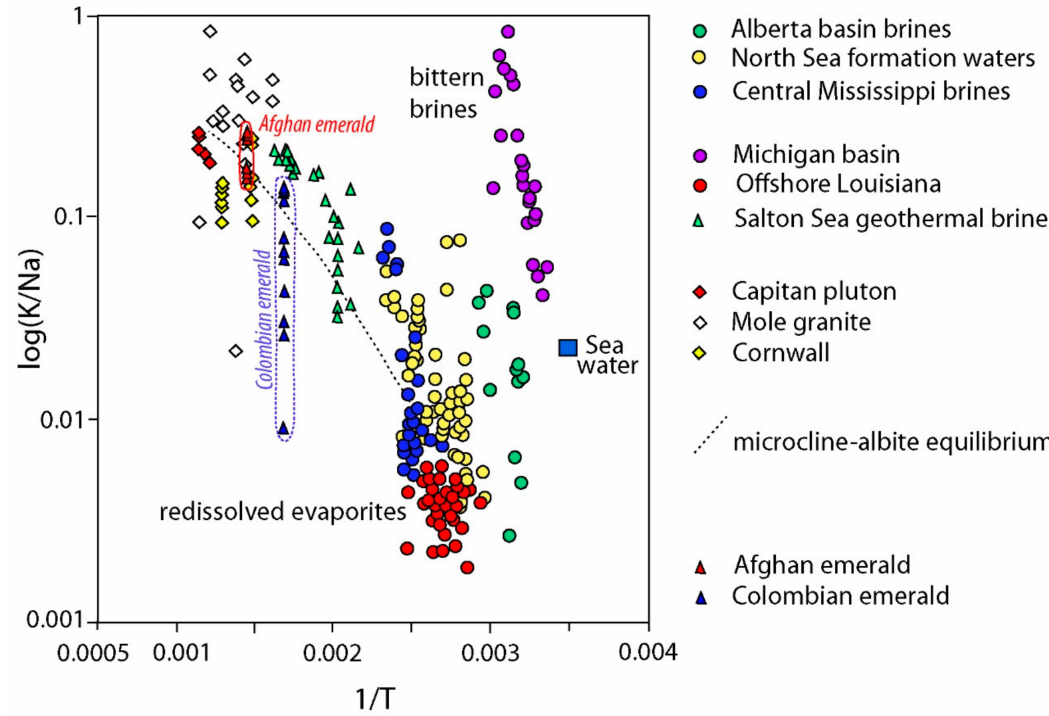
Figure 35. Diagram log (K/Na) molar ratio versus 1/T ( ◦ K) showing the evolution of the fluids associated with Colombian and Afghan emeralds relative to crustal fluids, including bittern brines, brines derived by dissolution of evaporites, and magmatic fluids. Sedimentary formation brines deviate significantly from the K-feldspar-albite equilibrium as well as for Afghan and Colombian brines, which are associated with a huge albitisation of their host-rock with the complete consumption of K-feldspar from, respectively, the schist and black